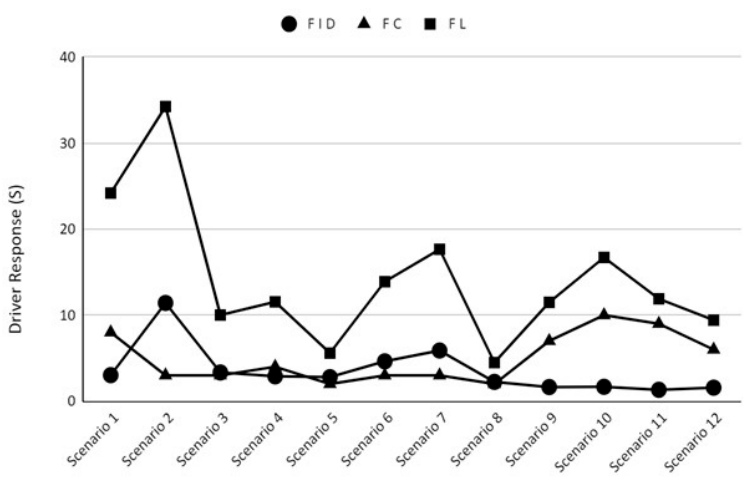
Figure 13. Responses of one driver to various hazard scenarios in the morning driving condition.